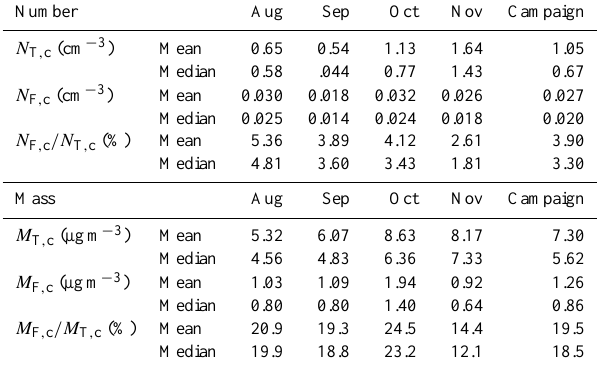
Table 1. Integrated number concentrations (a) and mass concen- trations (b) of coarse TAP and FBAP (1–20µm): arithmetic mean and median for each month (August–November) and for the entire measurement campaign (3 August–4 December 2006).